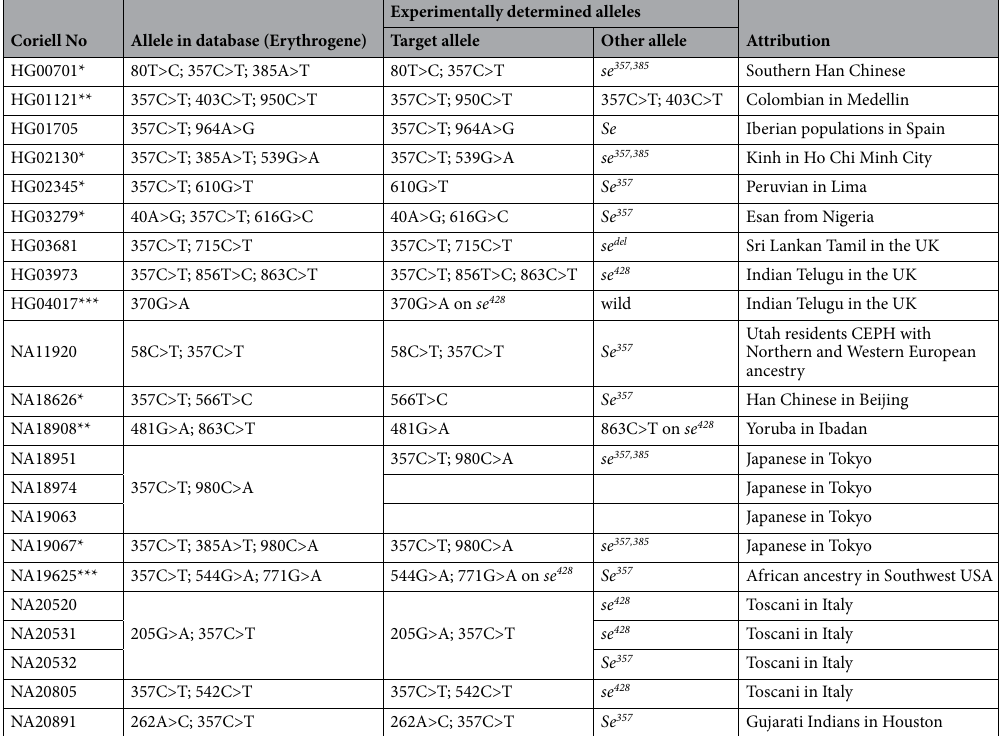
Table 2. DNA samples and relationship between FUT2 alleles on database and experimentally determined. Note: Asterisks represents samples whose experimentally determined FUT2 haplotype was different from that in the Erythrogene database. *Functional analysis was performed. **Functional analysis was not performed because it was already characterized. ***Functional analysis was not performed because target SNP was on se 428 .